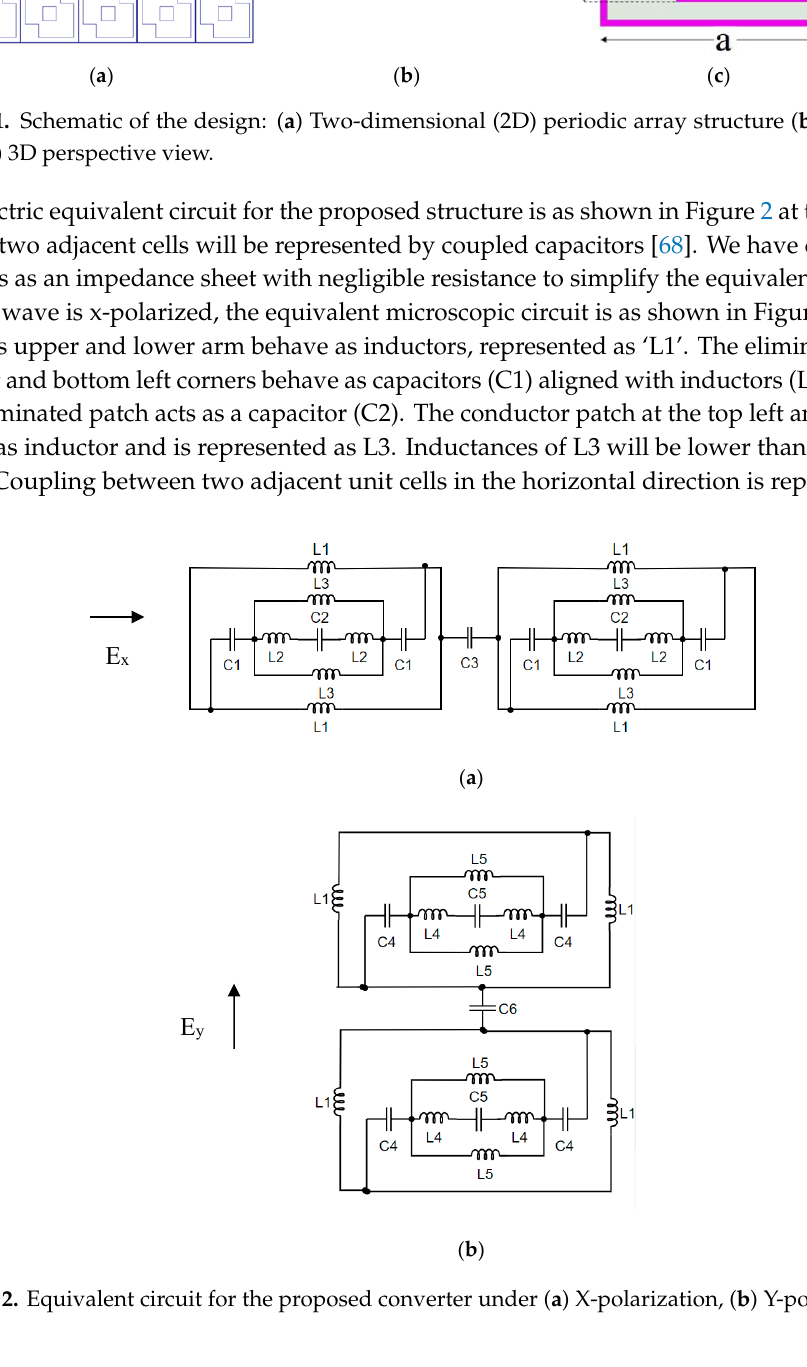
( b ) Figure 3. Transmission characteristics with incident ( a ) x-polarized ( b ) y-polarized waves.